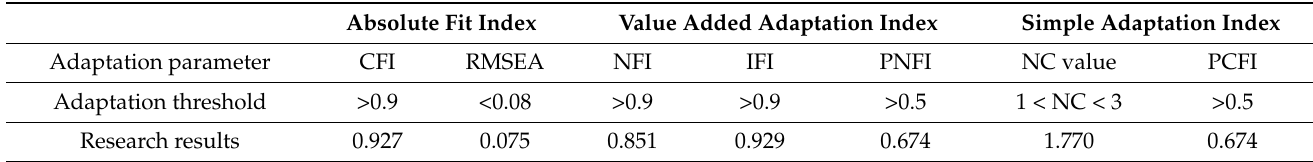
Table 4. Suitability evaluation of subway station entrance landscape efficiency model (obtained by AMOS software